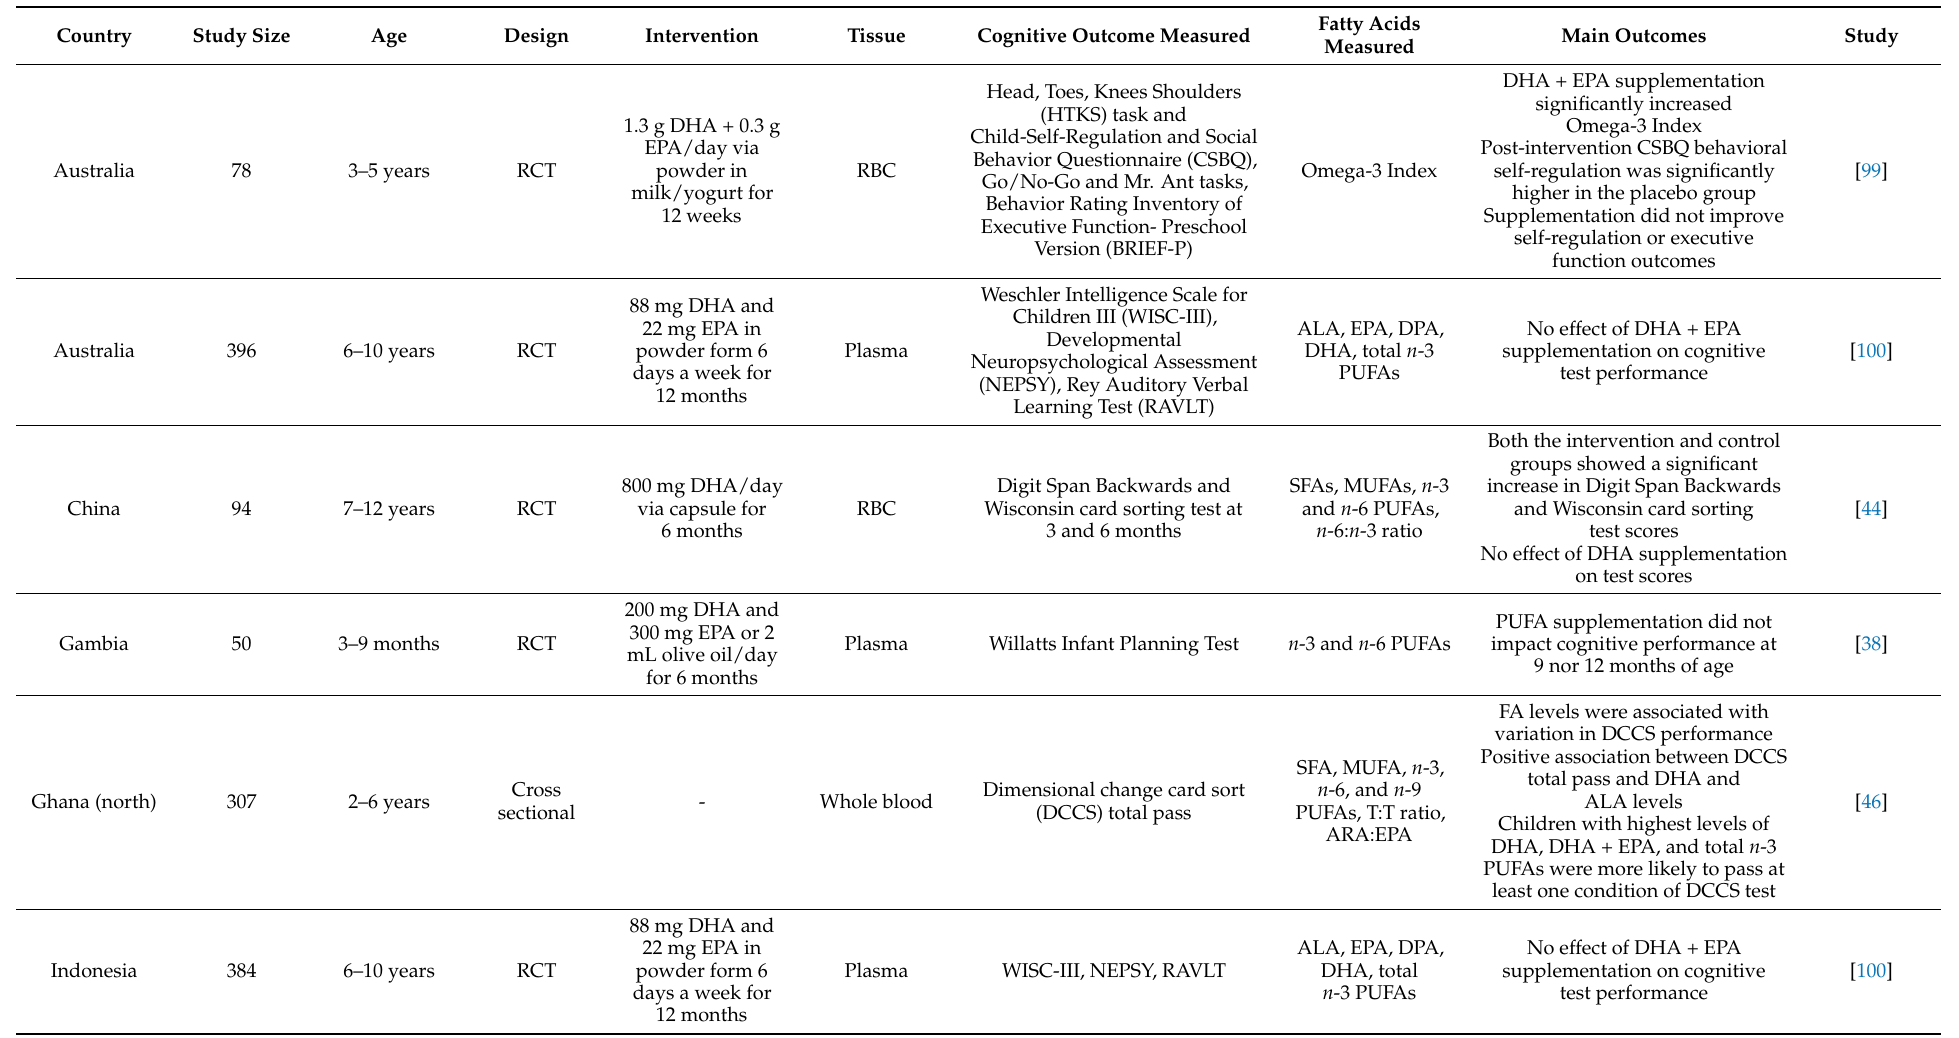
Table 3. Associations between blood fatty acid levels and cognitive outcomes among child populations in different countries and